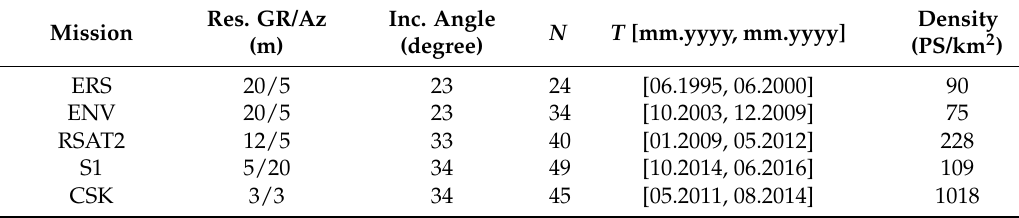
Table 2. For each satellite mission in Figure 2, the table reports: acquisition mode, resolution in ground range (GR) and azimuth (Az), number of images ( N ), observation time span ( T) , and spatial density of the coherent